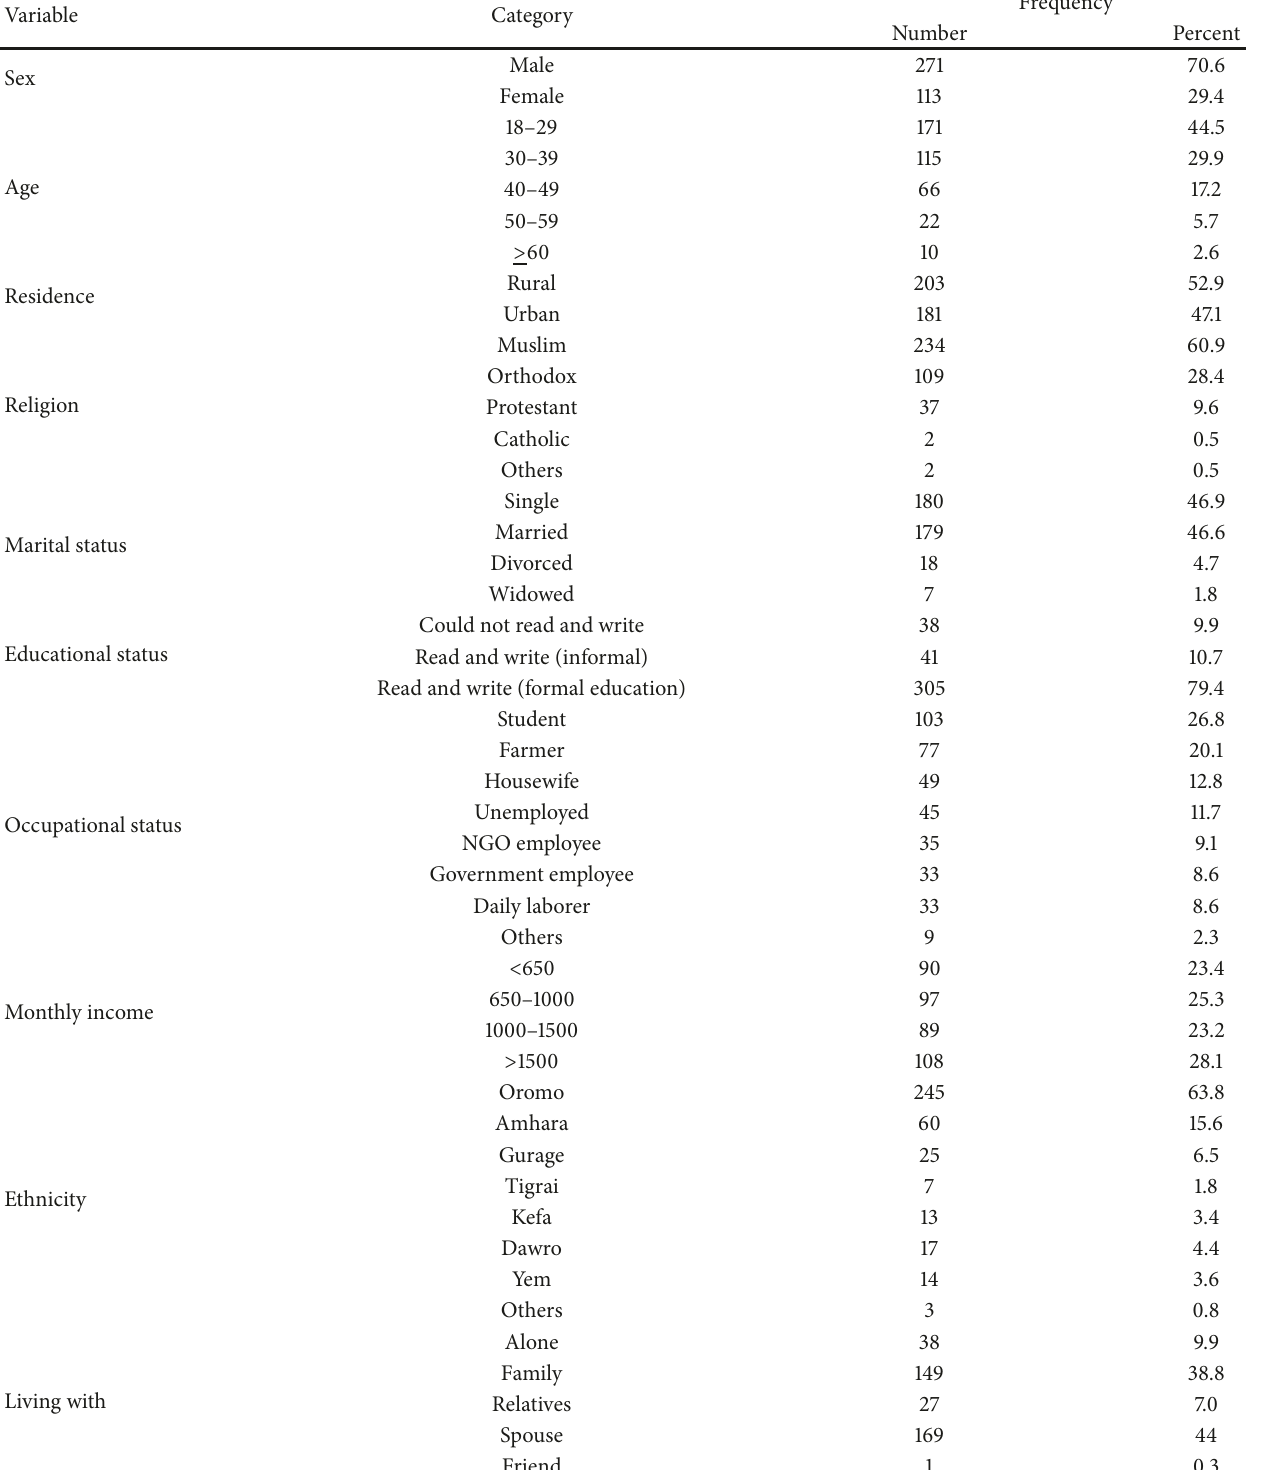
Table 1: Sociodemographic factors among adults with mental illness in JUSH,